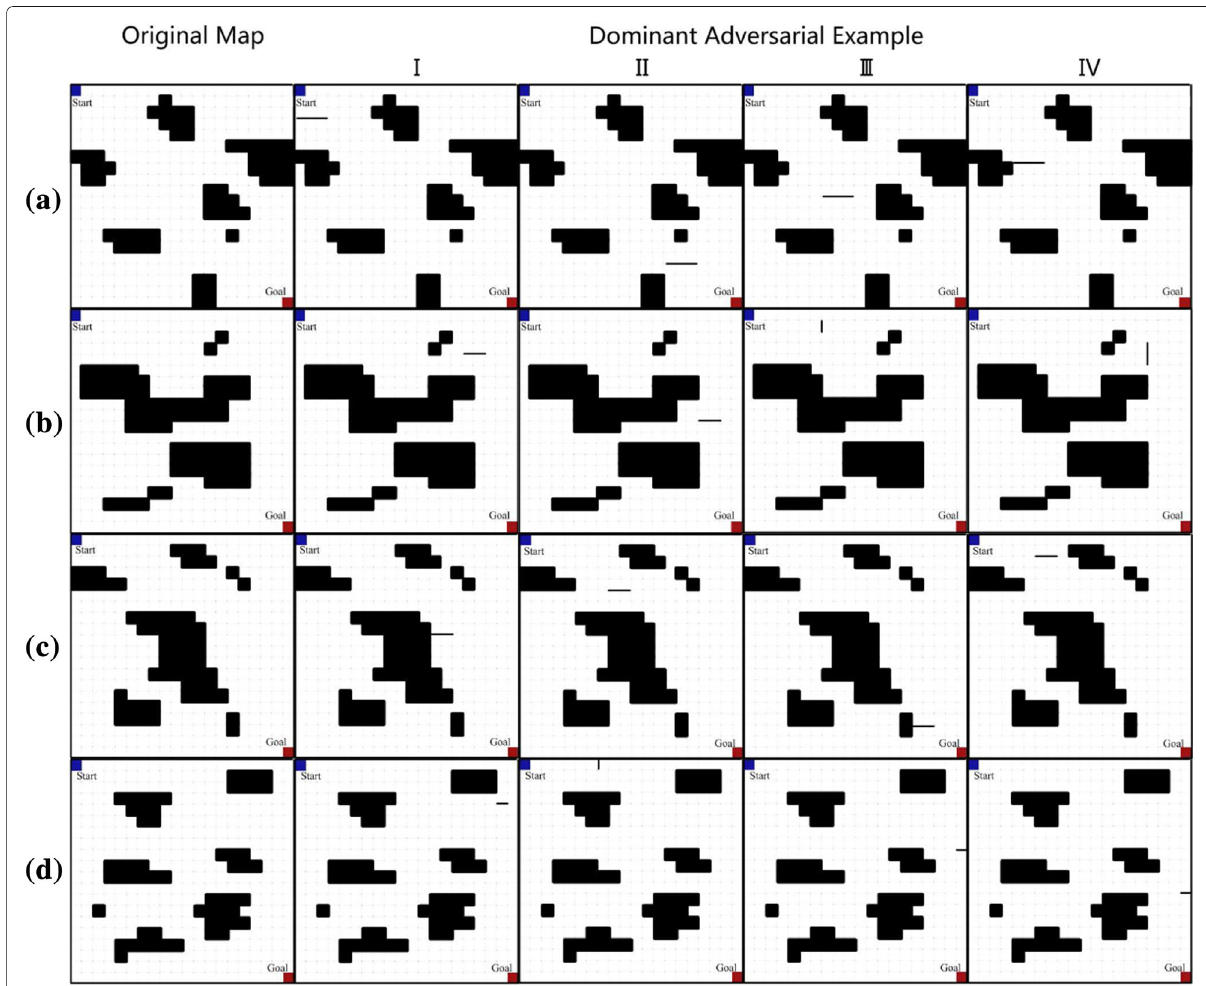
Fig. 5 Samples for Dominant Adversarial Examples. For the first column is the original clean map for path finding. For columns on the right are the samples for Dominant Adversarial Examples generated by CDG algorithm proposed in this paper, and ( a ), ( b ), ( c ), ( d ) represent four different samples for dominant adversarial